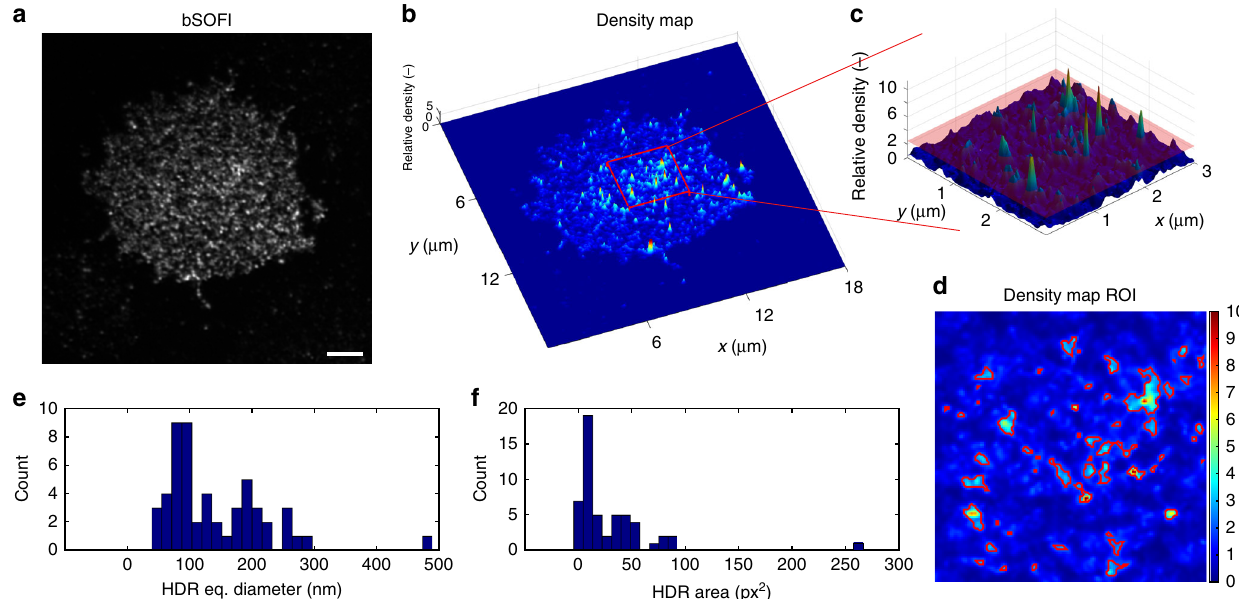
Fig. 2 Example of data processing for a single cell expressing wild-type CD4-mEos2 fusion protein. First, bSOFI image a is generated and a molecular density map b is calculated. Segmentation of clusters in the 3 × 3 µ m region of interest (ROI) as indicated in b is performed for each molecular density by monotonically increasing the threshold (an example is shown for a relative density threshold equal to 2.2 times the mean density ( c , d ). For each threshold, a histogram of equivalent diameters ( e ), i.e. diameter of a circle of the same area as the non-circular region, and a histogram of the measured area (px 2 ; f ) of high-density regions (HDRs) in the ROI shown in d are